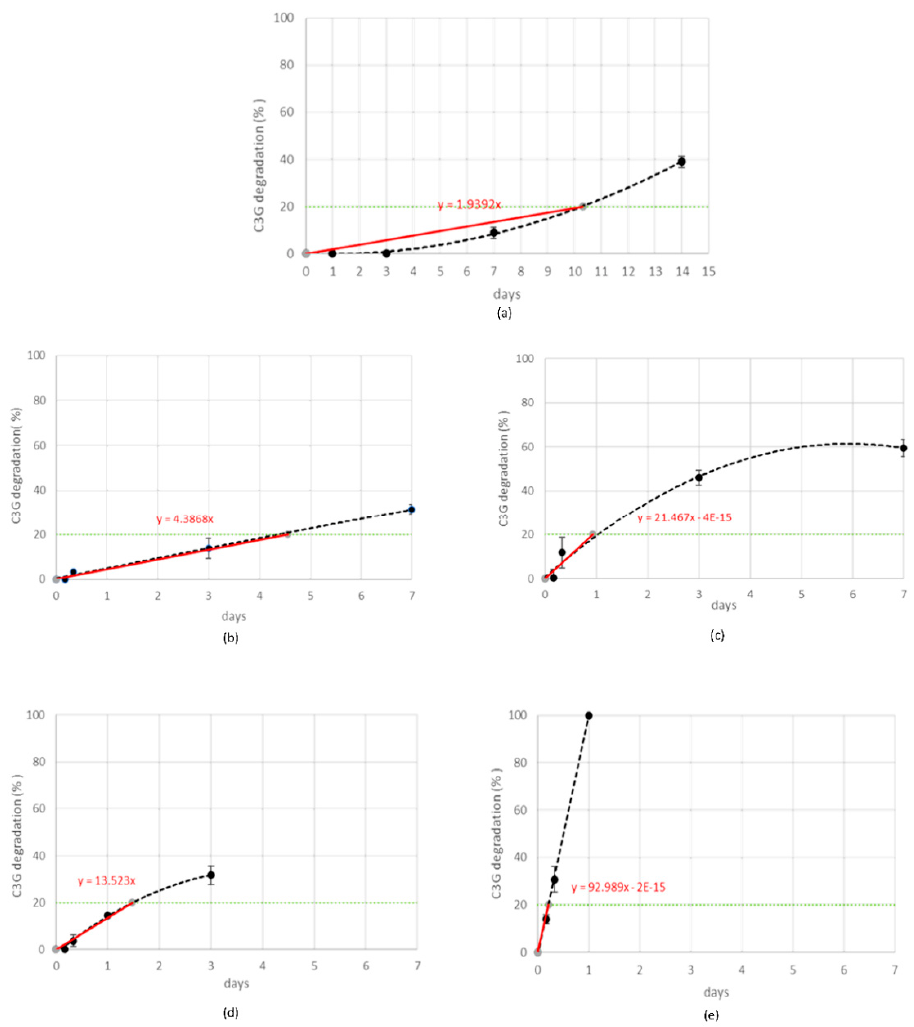
Figure 3. Cyanidin-3- O -glucoside (C3G) in MCE degradation kinetics (black line) when exposed to 25 °C-75% RH ( a ), 45 °C-30% RH ( b ), 45 °C-75% RH ( c ), 70 °C-30% RH ( d ), or 70 °C-75% RH ( e ). Experimental rate constants (ExpK) for each treatment were determined from the slope of the straight line (red line) passing from the origin and the specification limit (green line).